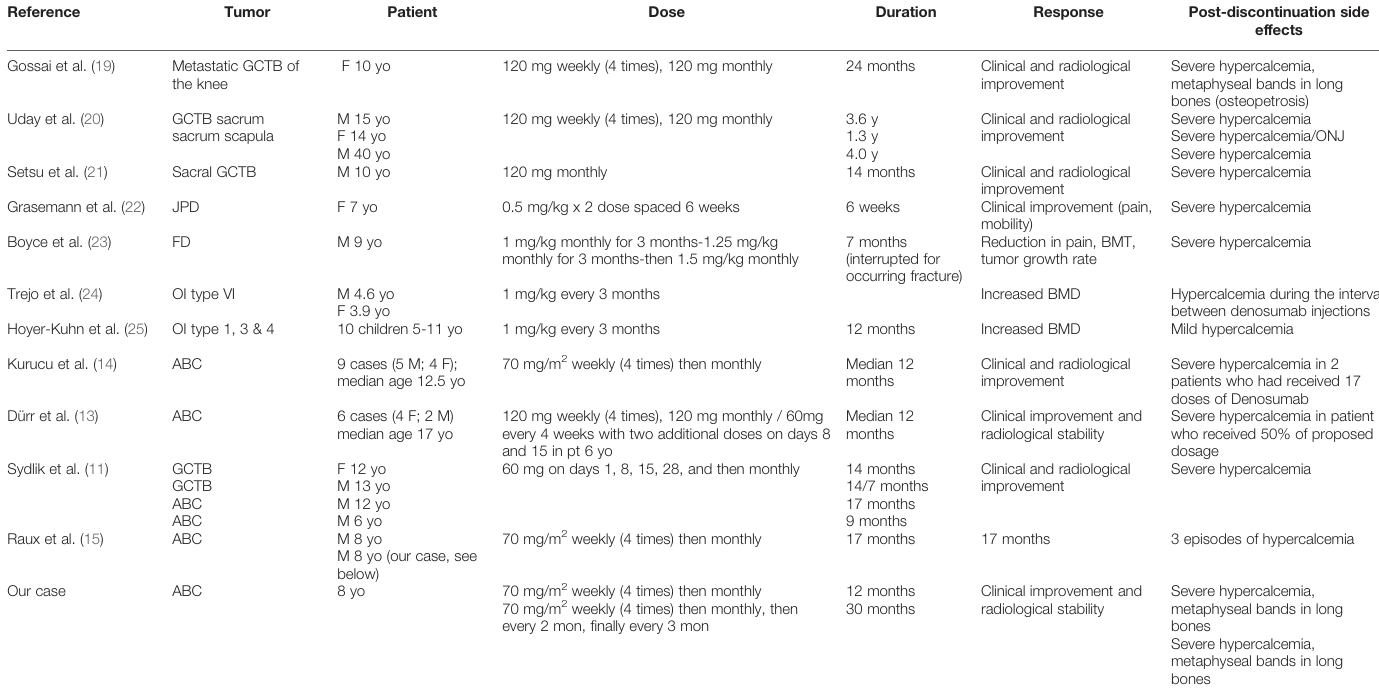
TABLE 2 | Post-discontinuation hypercalcemia after high dose denosumab in pediatric